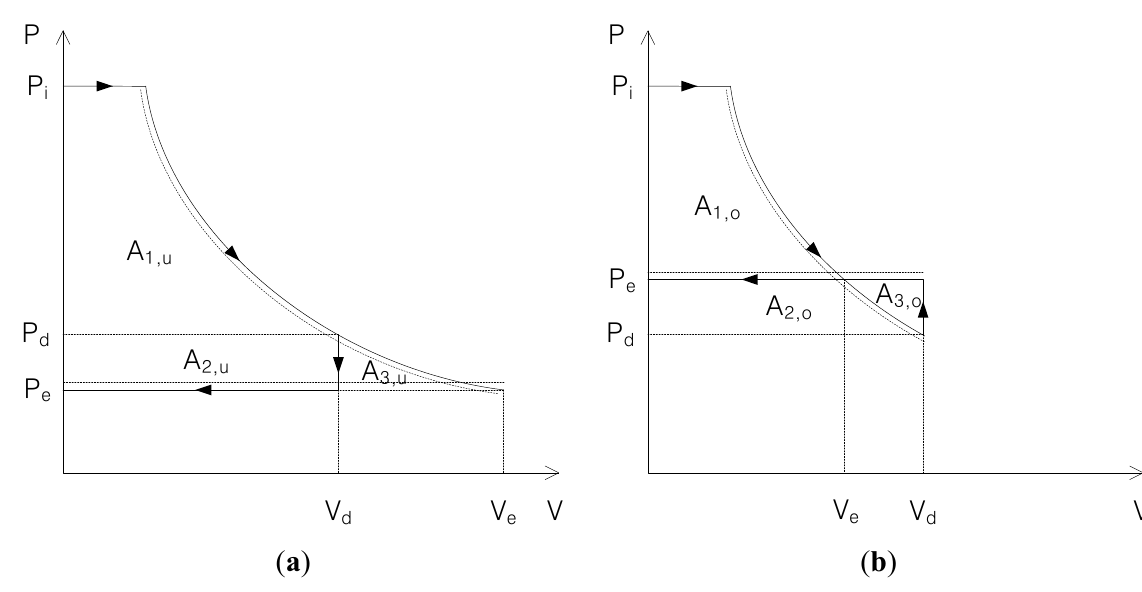
Figure 4. Isentropic expansion process in the pressure–volume diagram: ( a ) under-expansion and ( b )